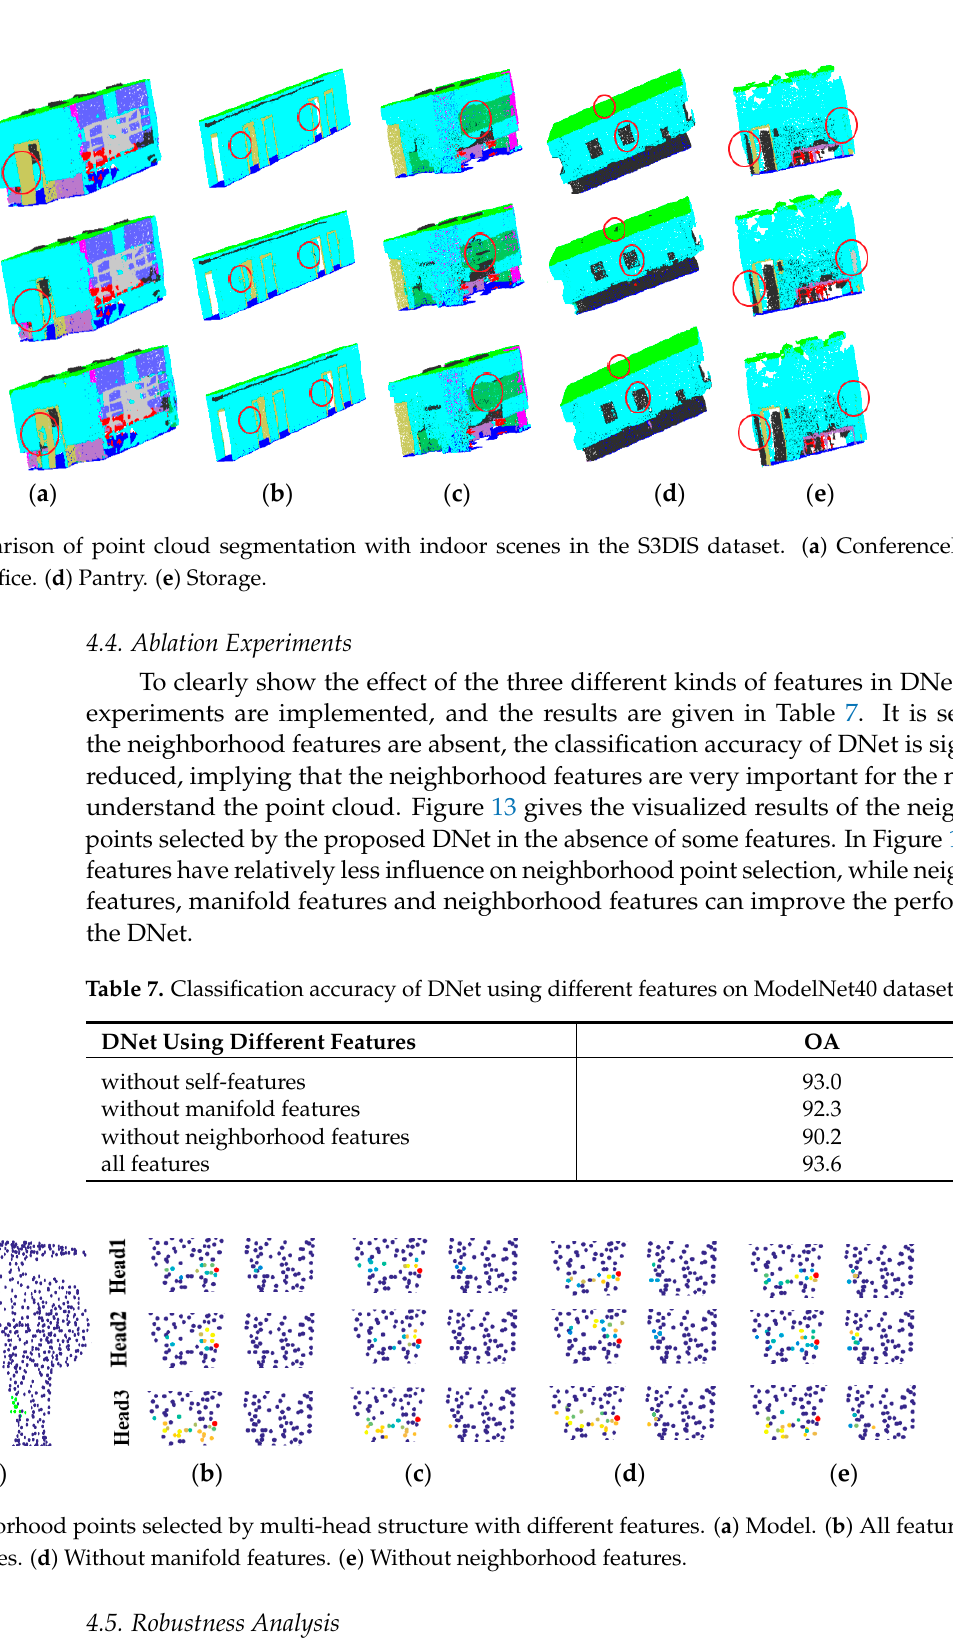
( e ) Figure 14. The influence of noise on the classification accuracy of different networks. ( a ) 10 noise points. ( b ) 50 noise points. ( c ) 100 noise points. ( d ) 200 noise points. ( e ) Classification accuracy. 5. Conclusions In view of the lack of an effective learning network for point cloud neighborhood selection, a new Dynamic neighborhood Network, known as DNet, has been proposed to extract effective neighborhood features in this paper. The proposed DNet has a mul- ti-head structure with two important modules: the Feature Enhancement Layer (FELay- er) and the masking mechanism. The FELayer enhances the manifold features of the point cloud, while the masking mechanism can suppress the effects of some pseudo neighborhood points, so that the network can learn features that are conducive to un- derstanding the local geometric information of the point cloud. In order to obtain suffi- cient contextual information in the proposed DNet, the multi-head structure is designed to allow the network to autonomously learn multi-scale features of a local region. The experimental results on three benchmark datasets have proved the effectiveness of the proposed DNet. The visualization results also show that the proposed DNet can capture more effective neighborhood features that are easy to understand.